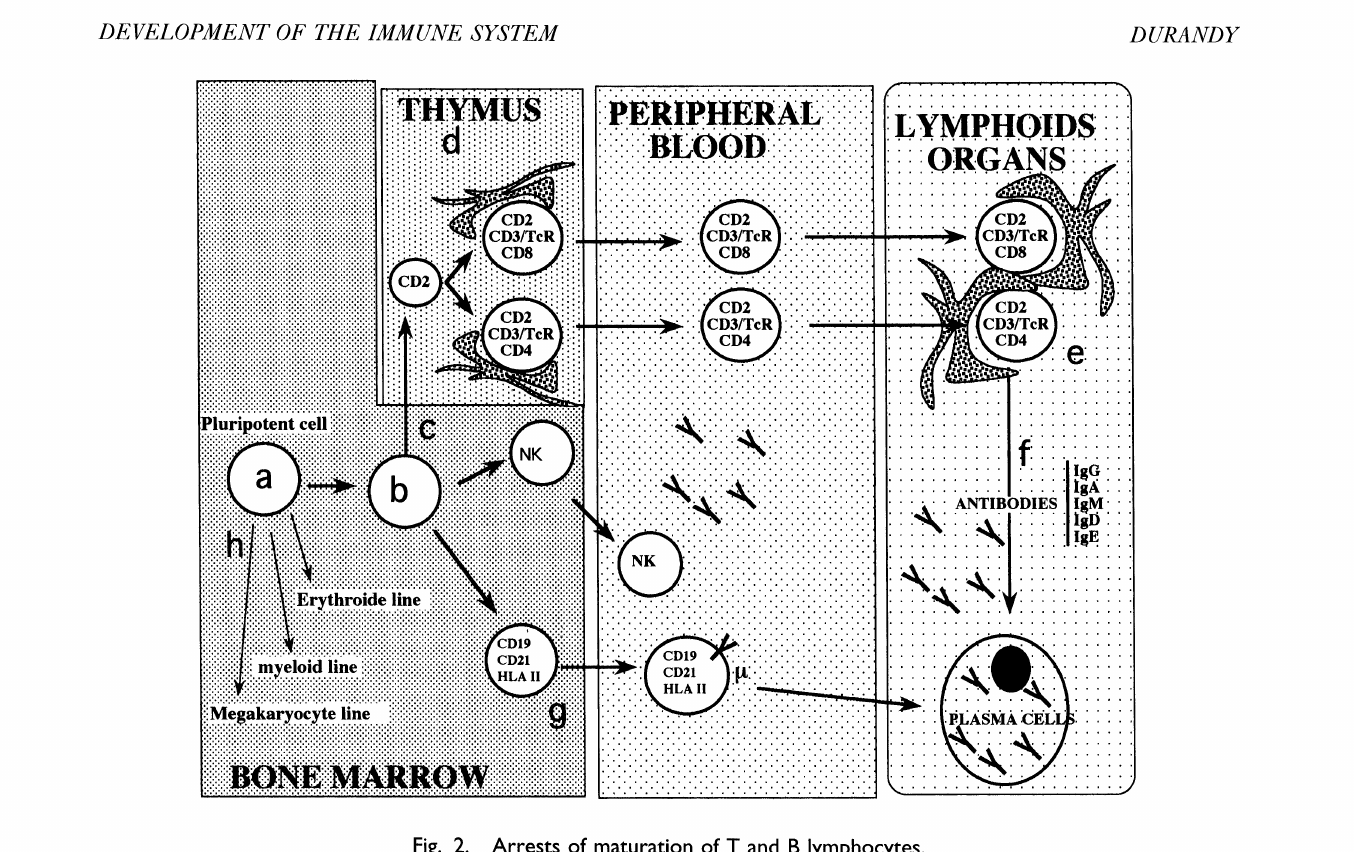
Fig. 2. Arrests of maturation of T and B